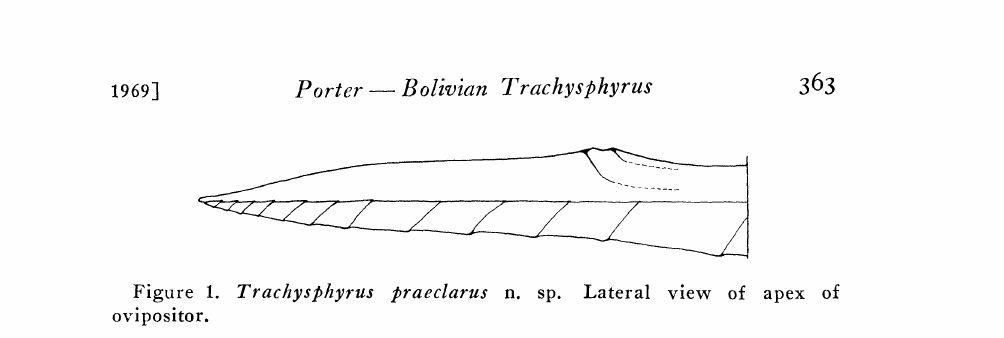
Figure 1. Trachyslhyrus praeclarus n. sp. Lateral view of apex of